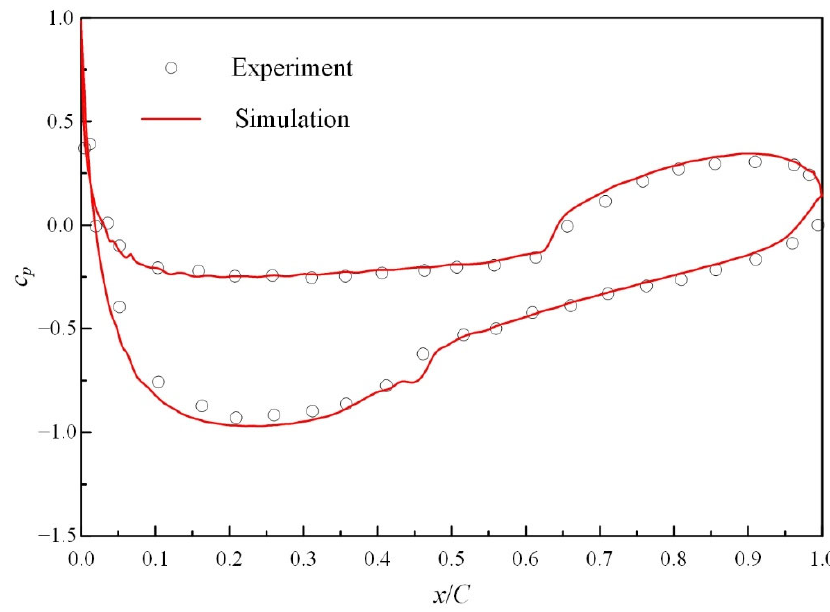
Figure 3. Pressure coefficient around NLF(1)-0416 airfoil.